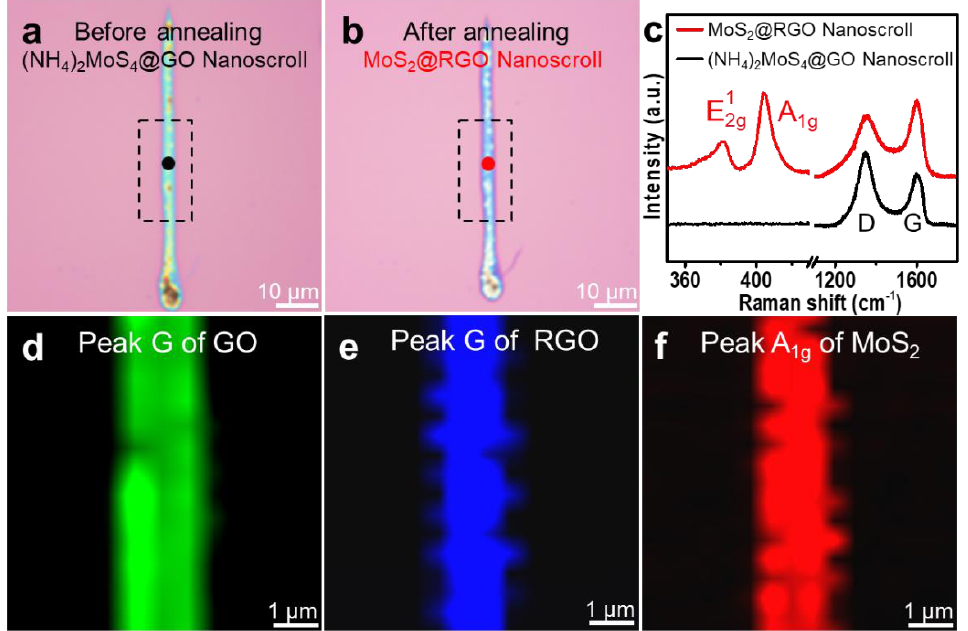
Figure 1. The OM images of the (NH 4 ) 2 MoS 4 @GO nanoscroll ( a ) before and ( b ) after thermal annealing. ( c ) Raman spectra of the (NH 4 ) 2 MoS 4 @GO and MoS 2 @RGO nanoscrolls. The Raman mapping images of ( d ) the (NH 4 ) 2 MoS 4 @GO nanoscroll and ( e ) the RGO at peak G (1587cm − 1 ), and the MoS 2 @RGO nanoscroll at peak ( f ) A 1g (404.2 cm − 1 ) of MoS 2 .